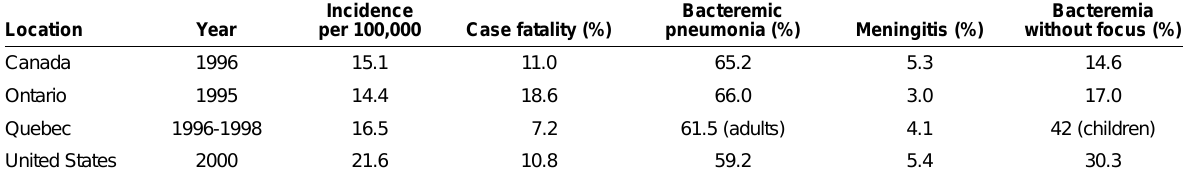
TABLE 1 Invasive pneumococcal disease in Canada and the United